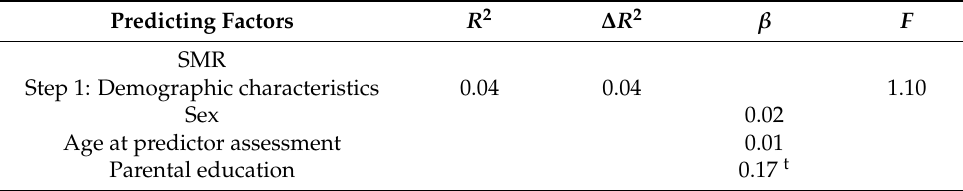
Table 3. Hierarchical regression analyses predicting sociomoral